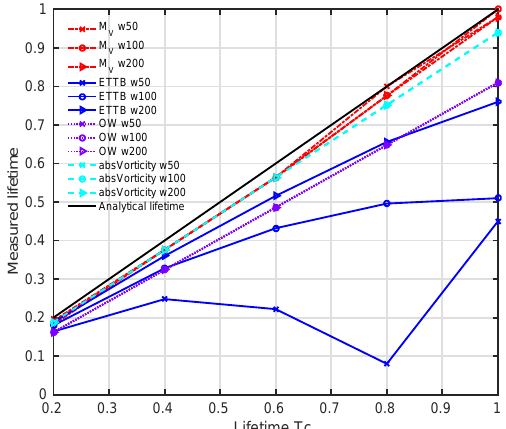
Figure 4. Eddy lifetime estimated with Okubo–Weiss (OW, vio- let); the modulus of vorticity (absVorticity, cyan); M V (red); and the eddy tracking tool box (ETTB, blue) by Nencioli et al. (2010) for vortex strength w 50, 100 and 200. The black diagonal depicts the analytical